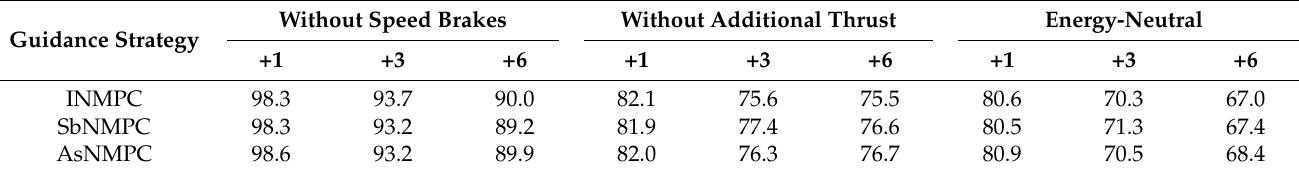
Table 2. Energy-neutral trajectories per guidance